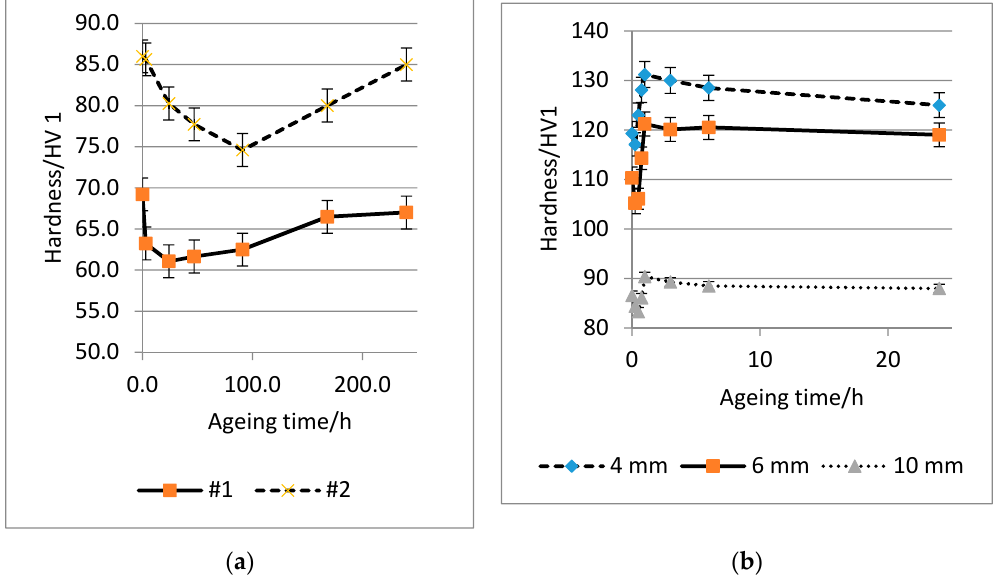
Figure 3. Hardness of the alloys in the as-cast state and after heat treatment. ( a ) Hardness of different alloys aged at 300 °C (sample diameter 10 mm), ( b ) hardness of different samples of the alloy Al 95.4 Mn 1.8 Cu 1.6 Be 1.2 heat-treated at 400 °C. (#1—Al 96.5 Mn 0.8 Cu 1.2 Be 1.5 , #2—Al 95.4 Mn 1.8 Cu 1.6 Be 1.2 ).